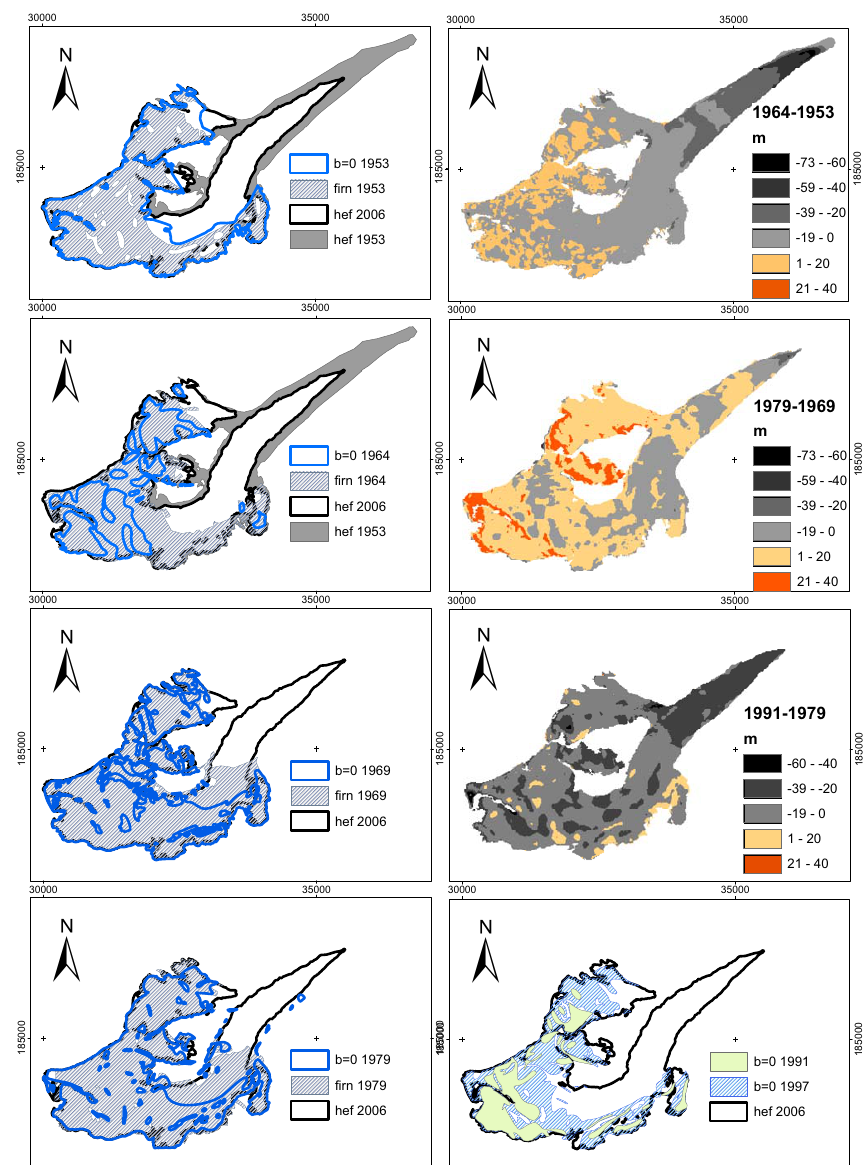
Fig. 13. Areas where b = 0, firn covered area and volume change for different years where DEMs were recorded. of strongly negative mass balances. Figure 13 shows the firn extent and the area covered with old snow for several years on HEF, when DEMs were recorded. It is evident that the ac- cumulation area differs from the firn area and from the area with volume gain. Therefore, a volume gain or loss does not indicate a mass balance gain or loss at one specific location. As a result, the mean density for calculating the geodetic mass balance must come from a source other than the